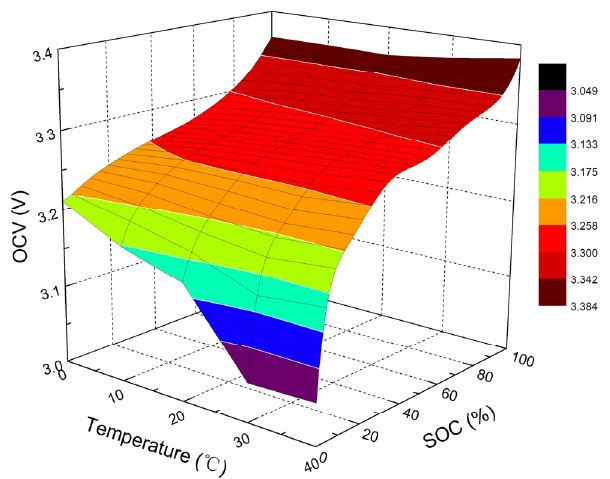
Figure 23. OCV PI –SOC–T relationship